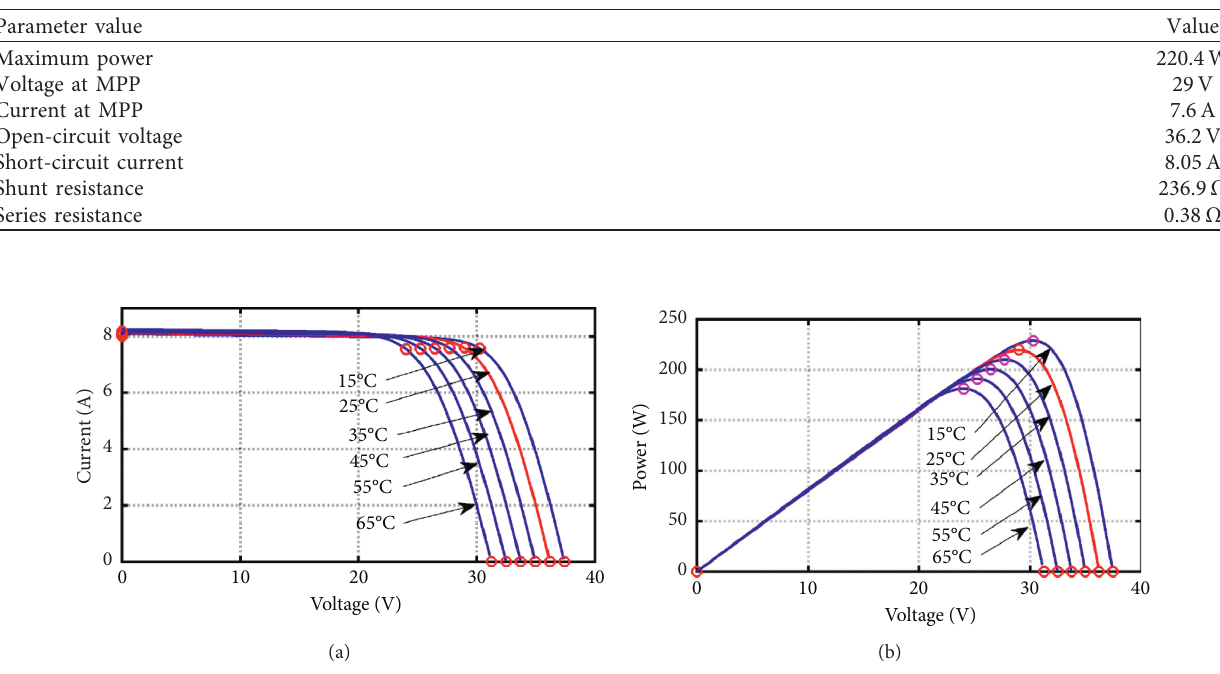
Figure 5: Simplified circuit of PV cell. Table 1: PV system parameters.